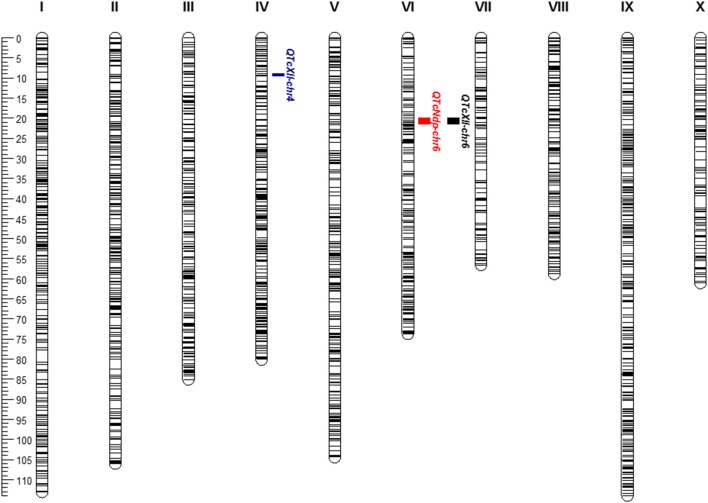
SNP-based linkage map and position of QTLs conferring resistance to CWC in the F1 population (“TSH 1188” vs. “CCN 51”). On the top of the chromosomes are the chromosome number, and the ruler is shown, with the positions of SNP markers in centimorgans (cM). Vertical bars on the right of the chromosome demarcate the location of the QTLs on chromosomes IV and VI.